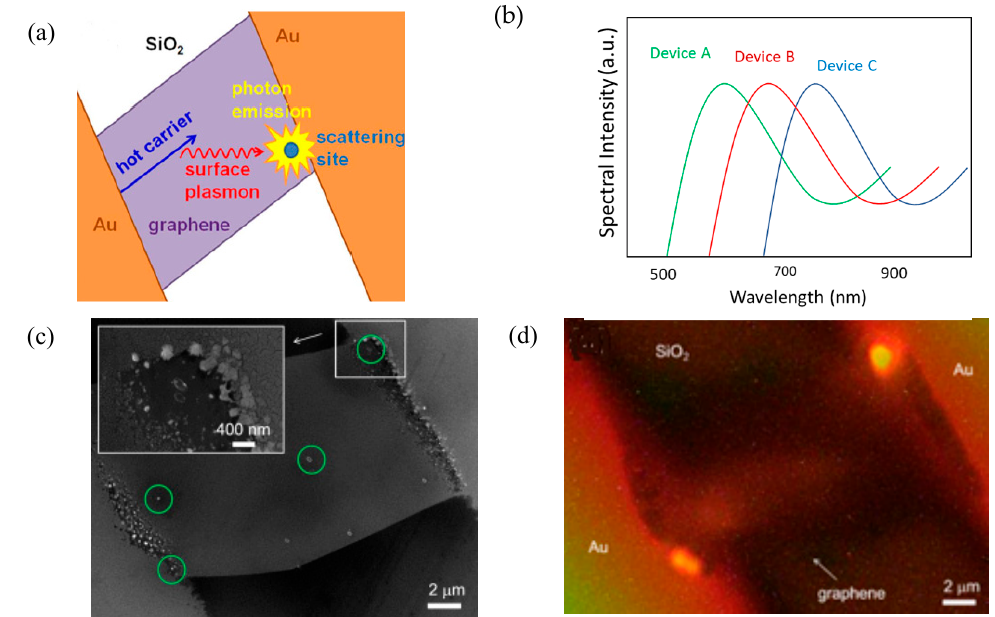
Figure 9 . ( a ) The schematic diagram of graphene light-emitting FET based on CE effect. ( b ) The graph shows the light emission spectral intensity versus emission wavelength for the three different devices A (green) (V G = 30 V, V DS = 7 V), B (red) (V G = 0 V, V DS = -30 V), and C (blue) (V G = 40 V, V DS = 18 V), with different channel lengths. The curves are well fitted to the Gaussian function presented with black lines. ( c ) SEM image of the device; the white rectangle shows the light-emitting area, the defected area of the graphene channel is highlighted by green circles. ( d ) The SEM image corresponds to emission from scattering sites